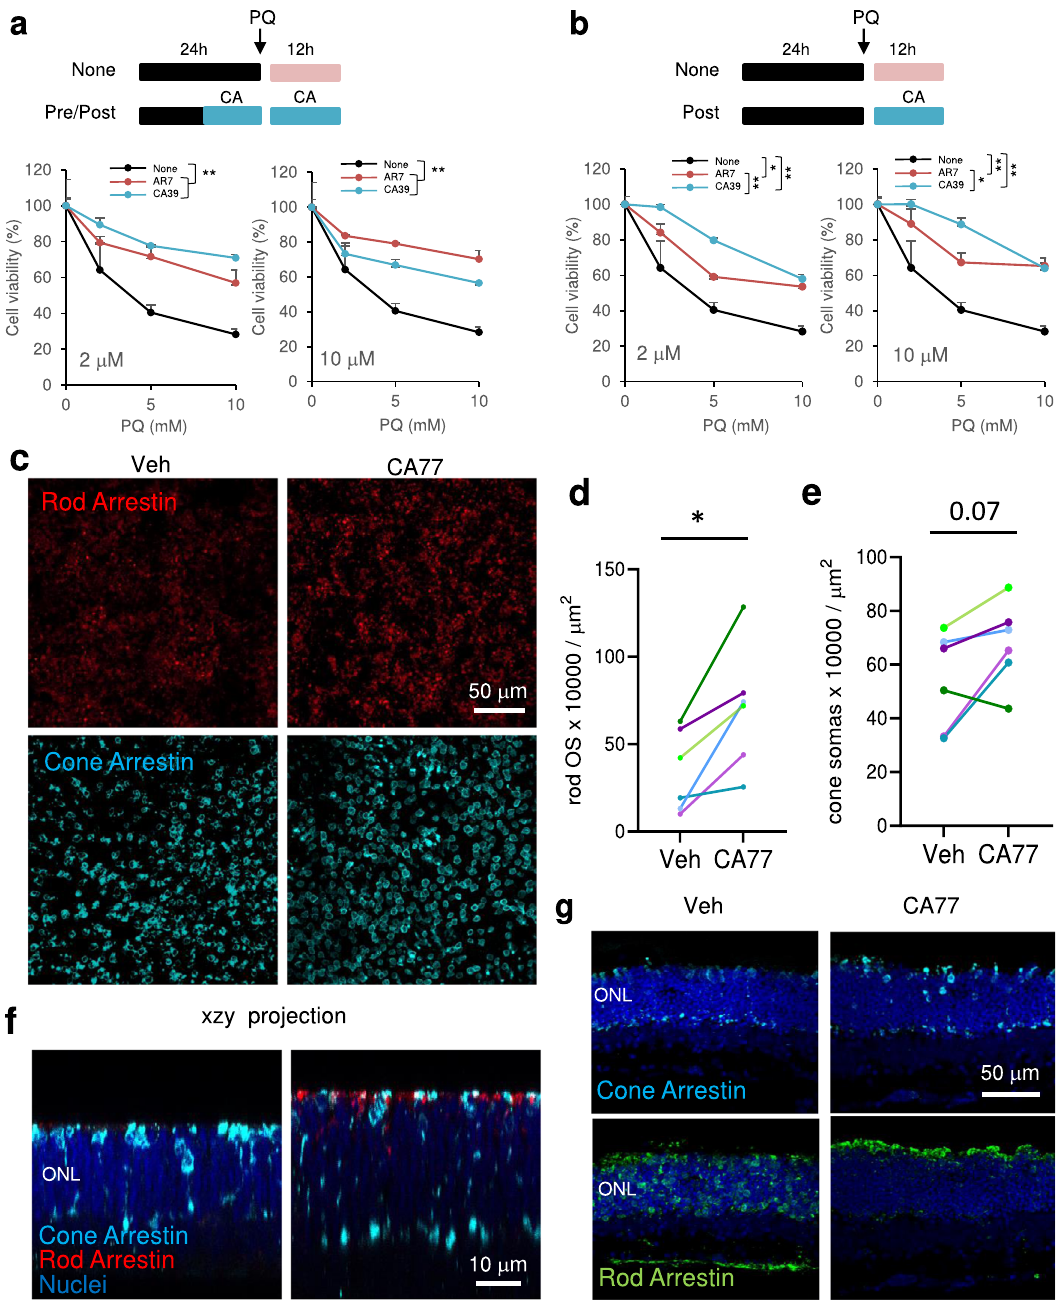
Fig. 5 CA compounds are cytoprotective in cells and tissues. a Cell viability of NIH3T3 exposed to the indicated concentrations of paraquat (PQ) after 12 h treatment with 2 μ M (left) or 10 μ M (right) the indicated compounds. The treatment with PQ alone (None) or in the presence of the compounds lasted 12 h. n = 3 independent experiments. b Cell viability of NIH3T3 simultaneously exposed to the indicated concentrations of paraquat (PQ) and 2 μ M (left) or 10 μ M (right) of the indicated compounds for 12 h. n = 3 independent experiments. c Immunostaining for the indicated markers of rods and cones in whole- mount retinas from rd10 mice maintained without additions (right eye; Vehicle (Veh.)) or in the presence of CA77 (left eye) for 72 h. Right: Quanti fi cation of the OS stained for rod arrestin ( d ) or number of cone arrestin-positive somas per fi eld ( e ) in retinas from the right and left eye of each animal. n = 8 mice (representative experiment from 3 independent experiments). All values are mean + s.e.m. f Orthogonal xzy projection corresponding to the areas above show from a different angle to better appreciate preserved ONL and rod and cone OS in CA77 compared to vehicle-treated mice. g Images showing staining with rod and cone arrestin in standard 12 µ m-cryosections show comparable results to those obtained by whole- fl at mounts. Two-way ANOVA followed by Bonferroni ’ s multiple comparisons posthoc test was used in a and b . Signi fi cant differences between treatments are shown in the legend and speci fi c differences between treatment for a given PQ concentration in the fi gure. Data from the three independent experiments in d to compare the effect of vehicle and CA77 on arrestin OS counts or cone arrestin soma numbers, were analyzed by paired two tailed t test. * p < 0.05 and ** p < 0.01. Source data and exact p values are provided as a Source Data fi